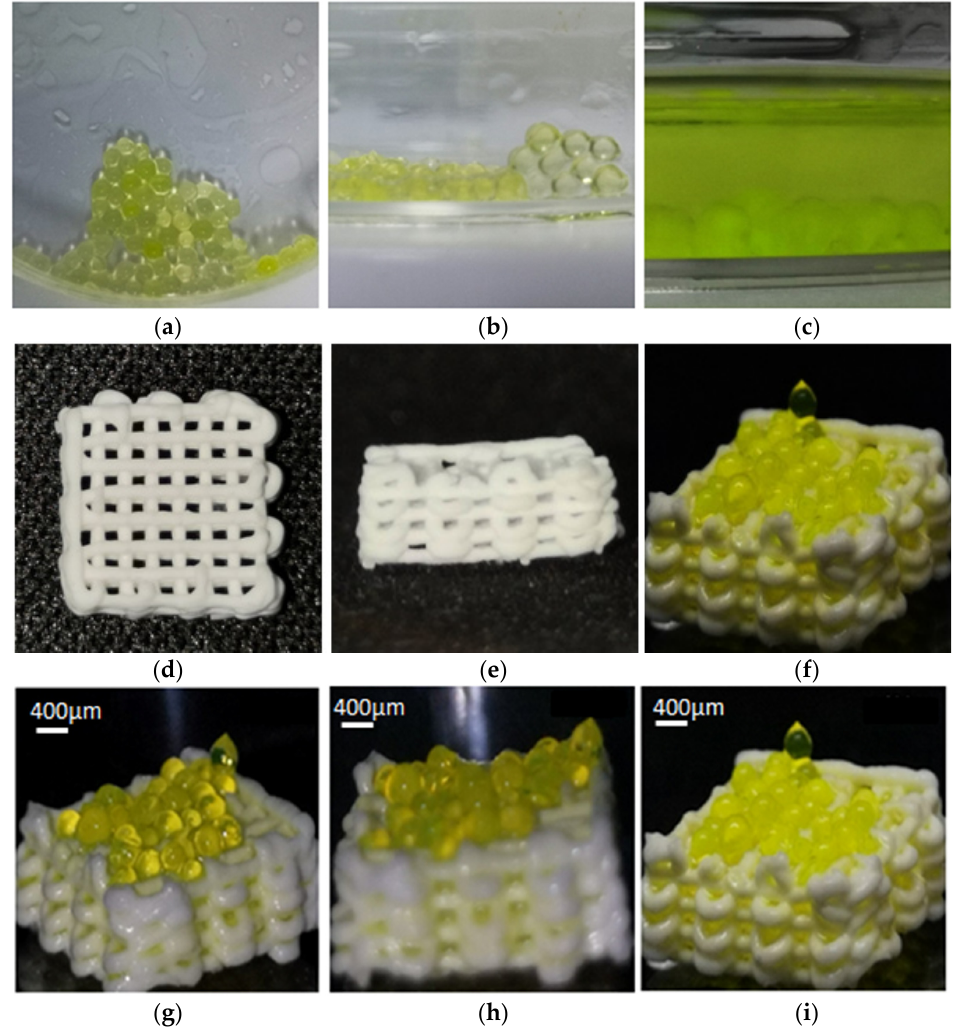
Figure 14. The state of cross-linked micro-droplets. ( a , b ) The morphology of microsphere droplets. ( c ) The shape of microsphere droplets in calcium chloride solution. ( d , e ) Biological scaffold. ( f – i ) The microsphere droplets are fixed on the biological scaffold superior.